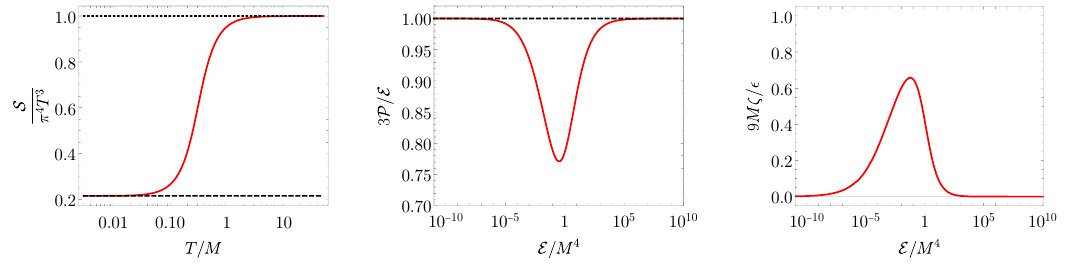
Figure 1 . (Left) Entropy density as function of temperature for φ M = 2 . The black dashed and dotted lines indicate respectively the IR- and the UV-limits (3.10). (Center) Ratio of reduced pressure to energy density as a function of the reduced energy density. (Right) Ratio of bulk viscosity to energy density as a function of the reduced energy